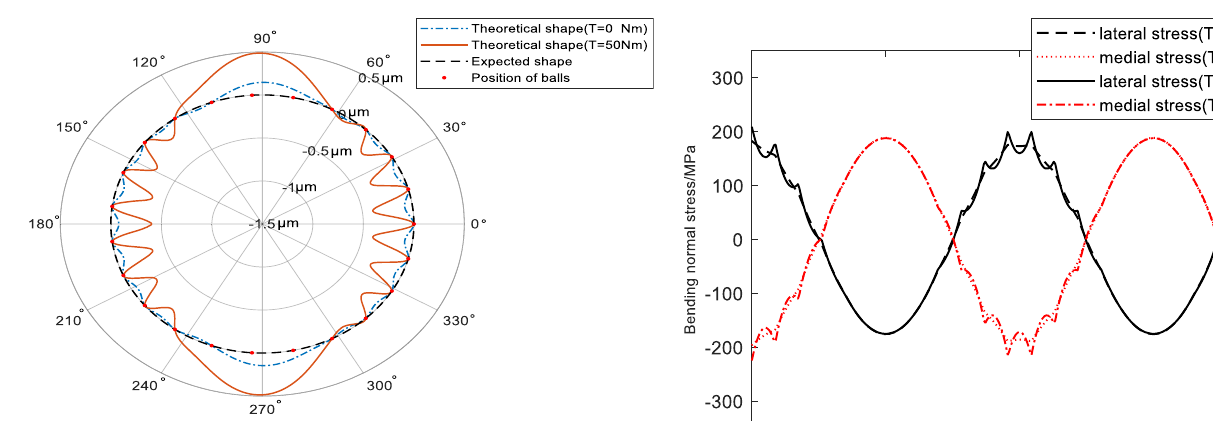
Fig. 12. Relationship of the difference of radial deformation and angular position under load.